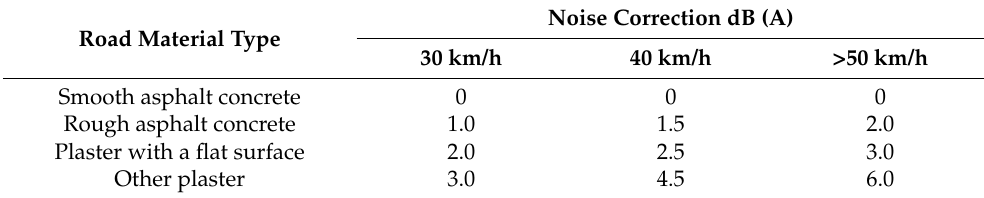
Table 1. Noise correction for different road materials and vehicle